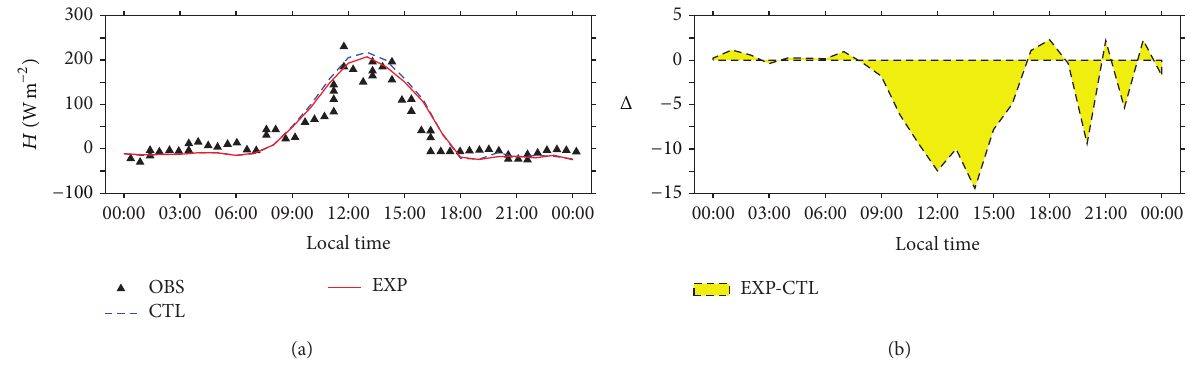
Figure 5: The same as Figure 4, but for sensible heat flux ( Wm −2 )